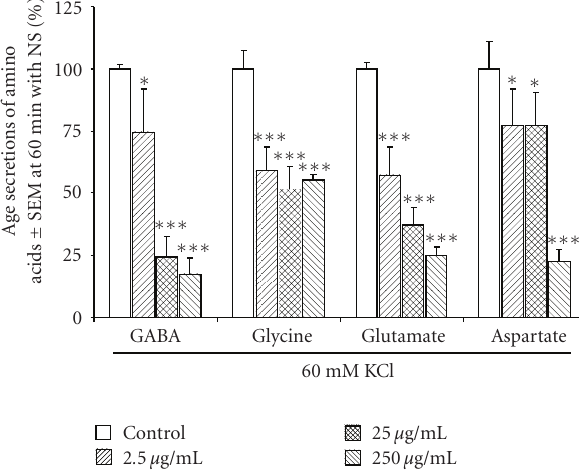
Figure 7: Secretion of amino acid neurotransmitters evoked by 60 mM KCl, measured in cortical neurons culture. The cells were previously treated with methanolic extract of Nigella sativa for 60 minutes. The values are expressed as a percentage of secretions with respect to basal value (100%). Statistical significances were calculated with respect to the corresponding control at its respective time points: ∗ P < . 05 and ∗∗∗ P < .